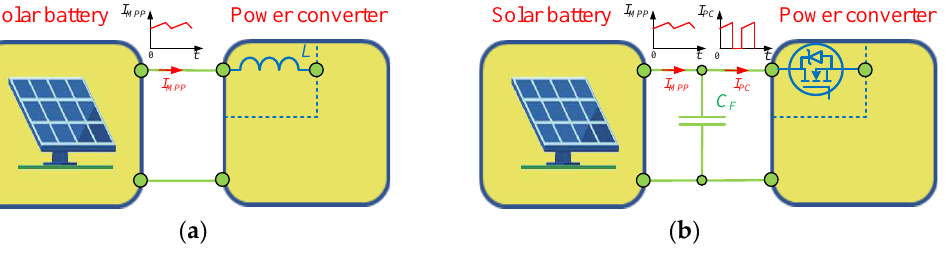
Figure 4. Providing continuous current: ( a ) natural for power converters with the series-connected inductor L ; ( b ) with an additional capacitor C F for a converter with a series transistor.